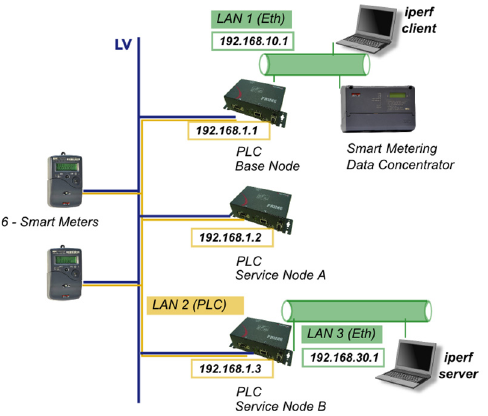
Figure 4. Multiservice network built over ITU-T G.9904 narrowband high data rate (NB HDR) powerline communications (PLC). Test setup.